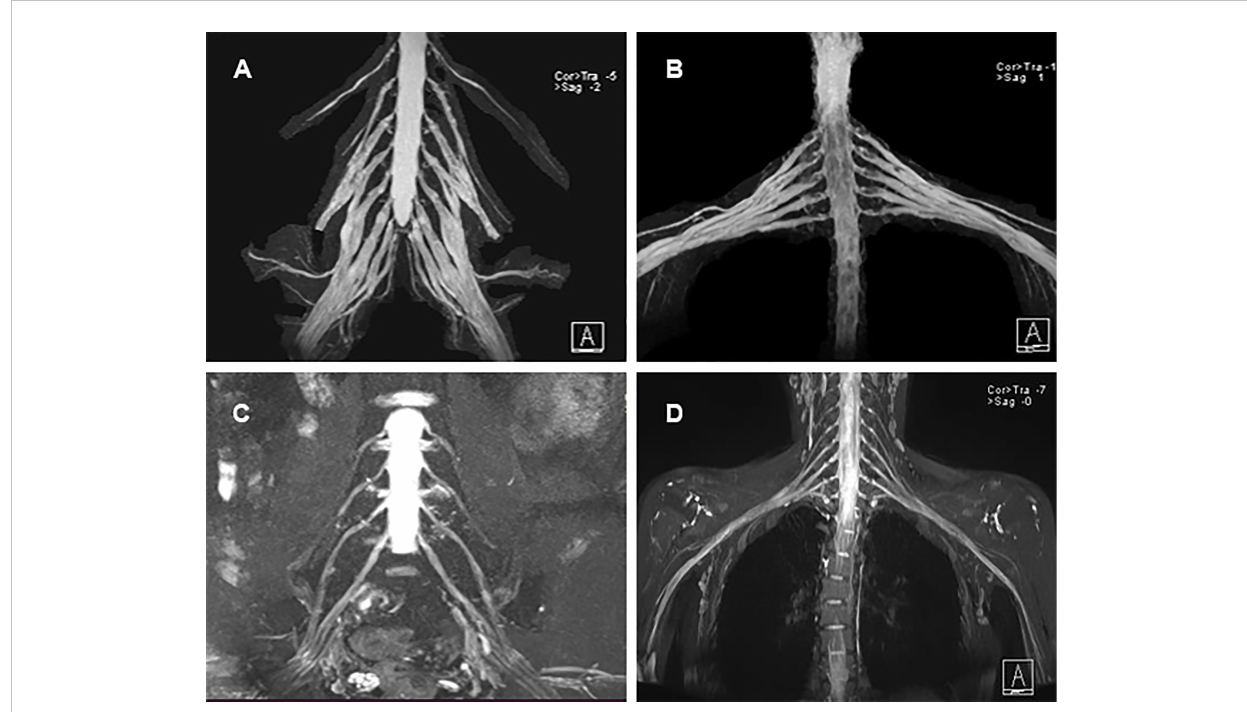
FIGURE 2 MRI neurography fi ndings. (A) Diffuse thickening of the cervical roots; (B) Diffuse thickening of the lumbosacral nerve roots; (C, D) Normal cervical roots and lumbosacral nerve roots of healthy